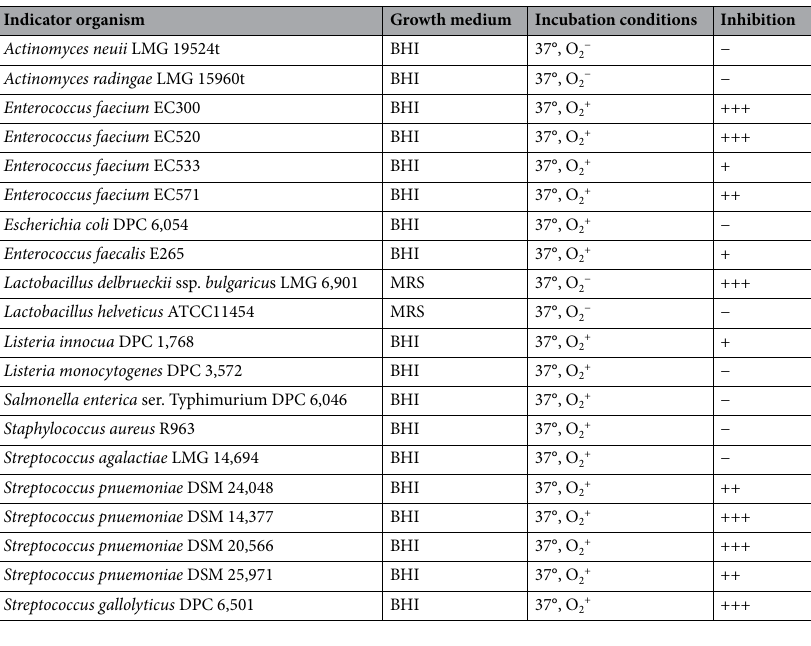
Table 4. Indicator organisms with growth conditions. Inhibition is represented by relative activities + 0.5–2 mm zone, ++ 2–4 mm zone, +++ > 4 mm zone + , and no inhibition −.